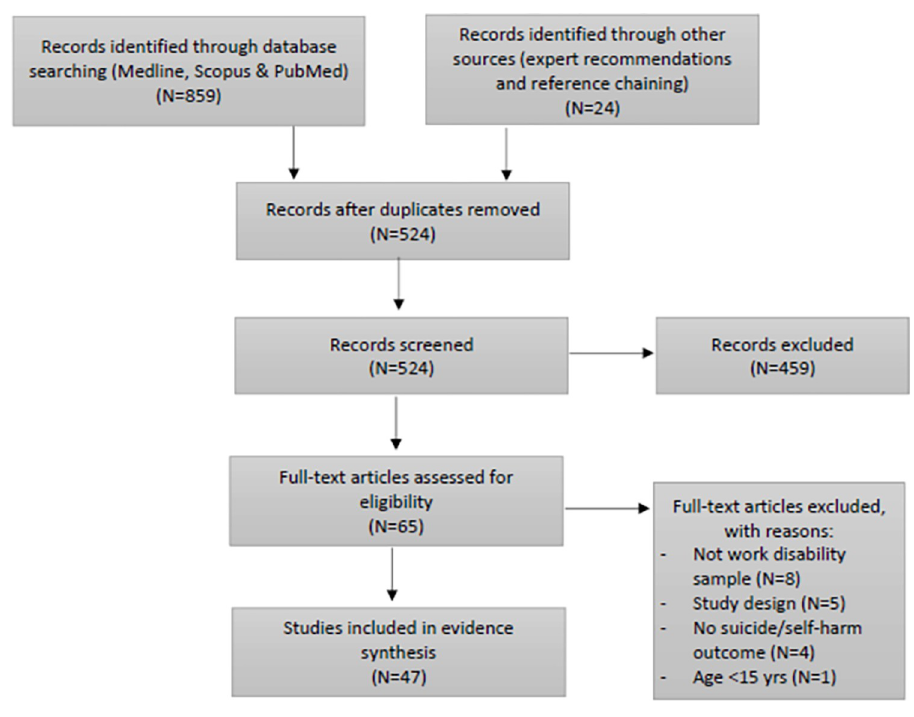
Fig 1. PRISMA flow